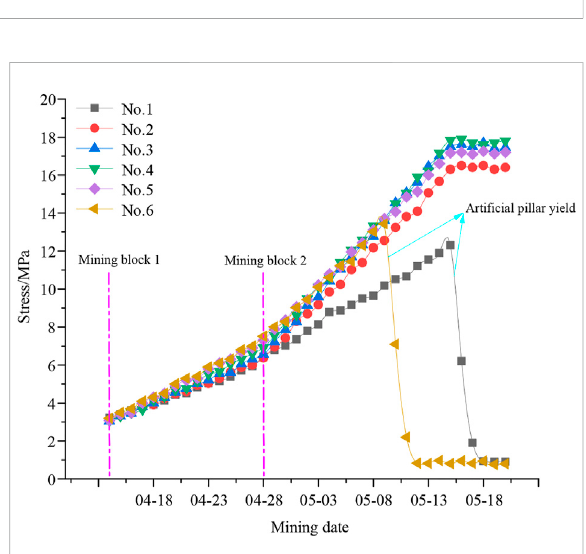
FIGURE 16 Arti fi cial pillar stress – mining date-change